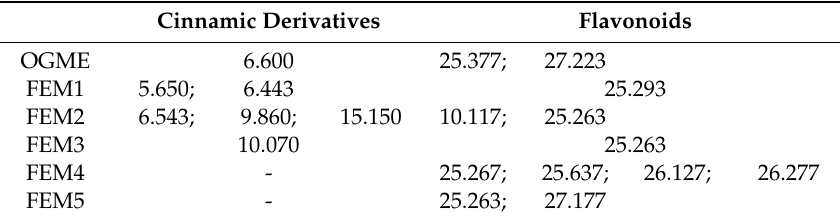
Table 1. Ocotea glomerata methanol extract and fraction components by High-Performance Liquid Chromatography (HPLC) (retention time in min).